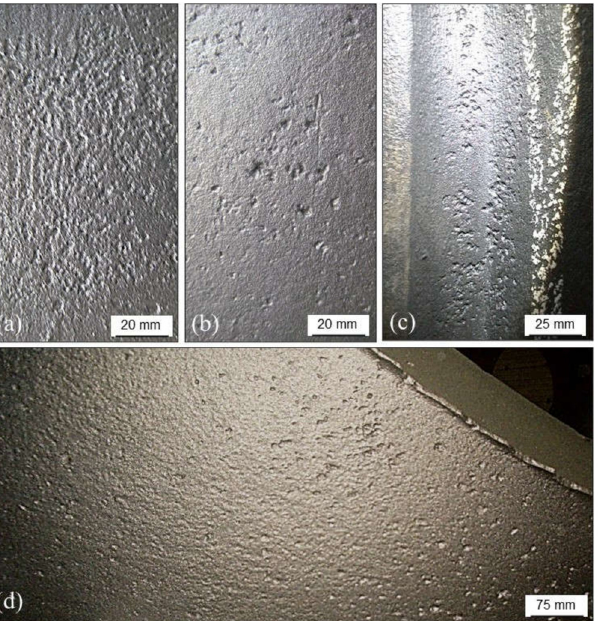
Figure 51. Different levels of pitting found in heavy-section ductile iron castings: detailed views ( a , b ) and general view ( d ) of the defect. Notice that defects only appear in the concave surface in ( c ), as it is the hottest